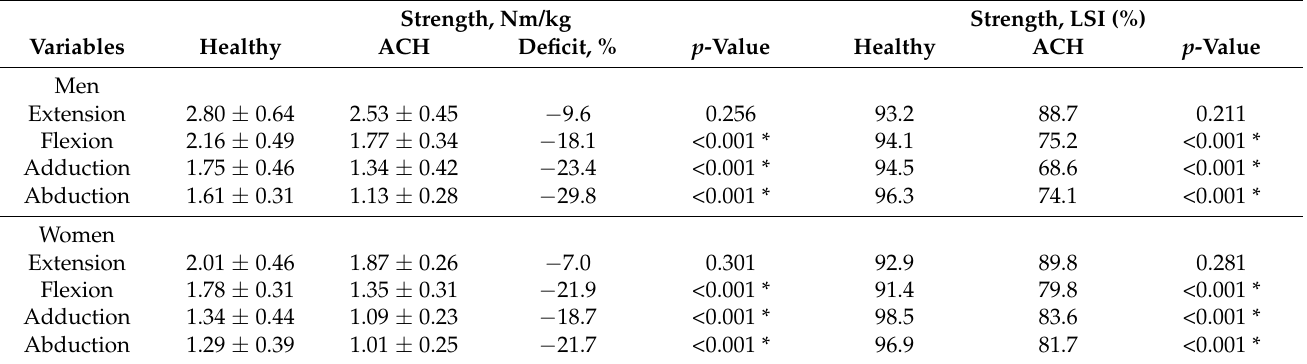
Table 3. Isokinetic strength of healthy controls and patients with